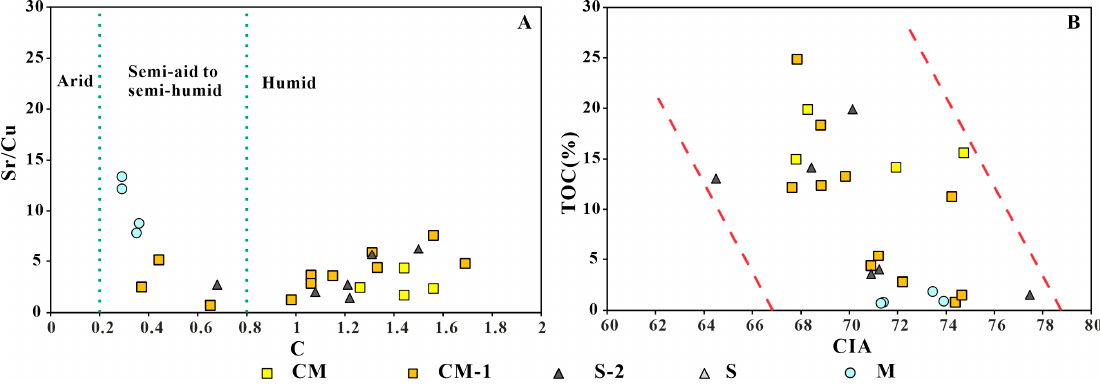
Figure 7. ( A ) Crossplots of C-value versus Sr/Cu contents. ( B ) Crossplots of CIA versus TOC contents for paleo-climate of the Chang 7 member in the Ordos Basin.